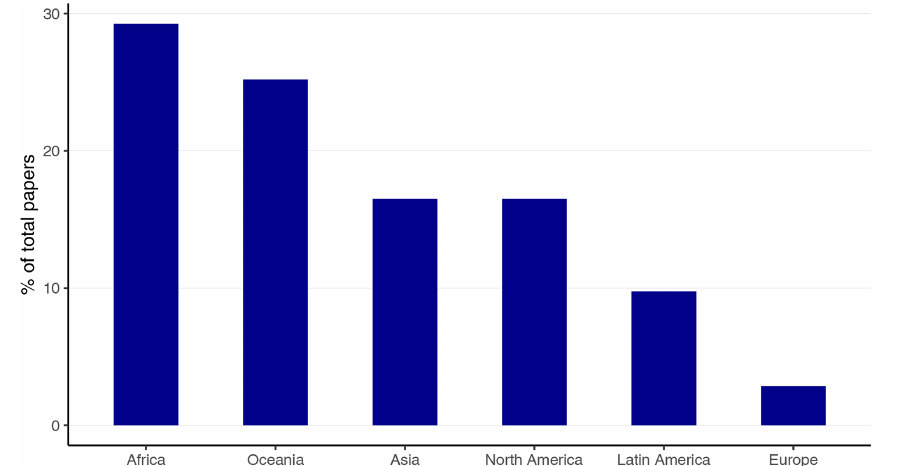
Figure 2. Continents (in percent of total papers) where the research was carried out that we found via a literature-mapping exercise (for details, see Appendix A).